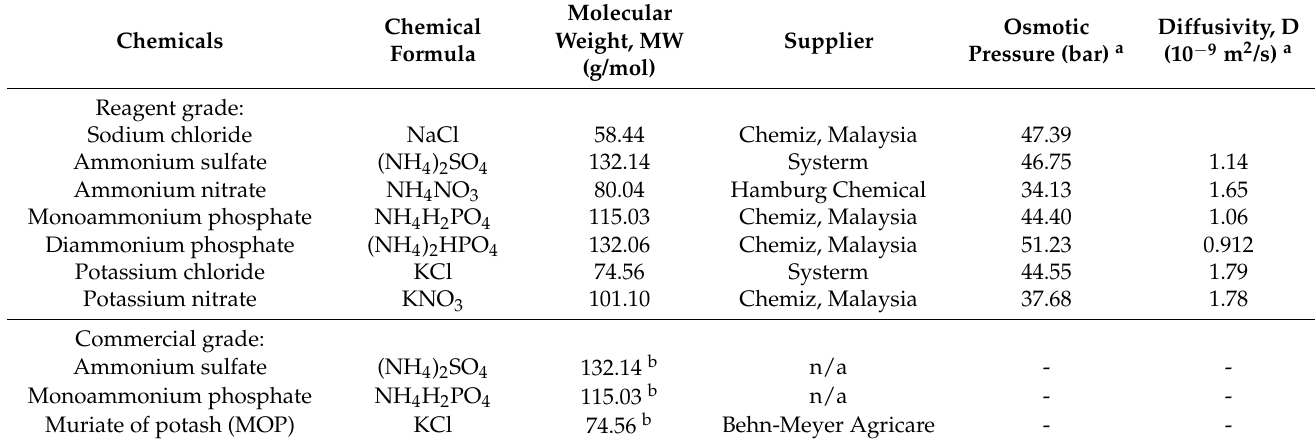
Table 3. Details and properties of fertilizers used as draw